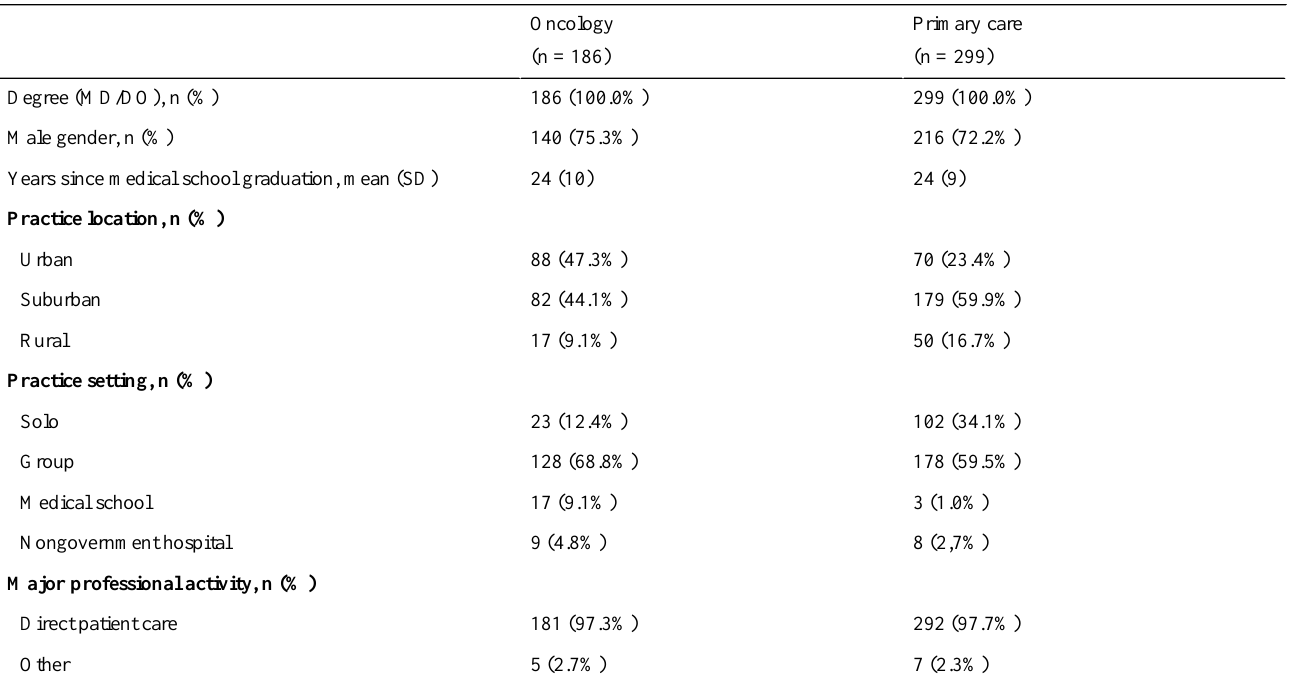
Table 1. Sample characteristics.